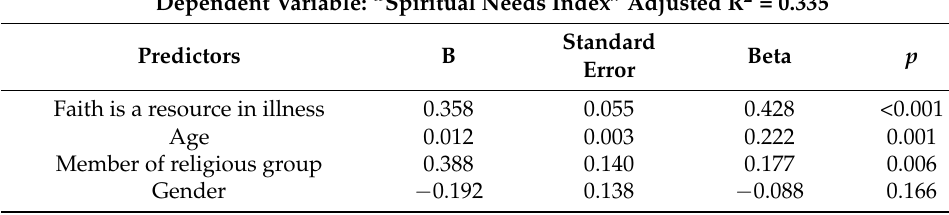
Table 5. Multivariate linear regression; “enter”